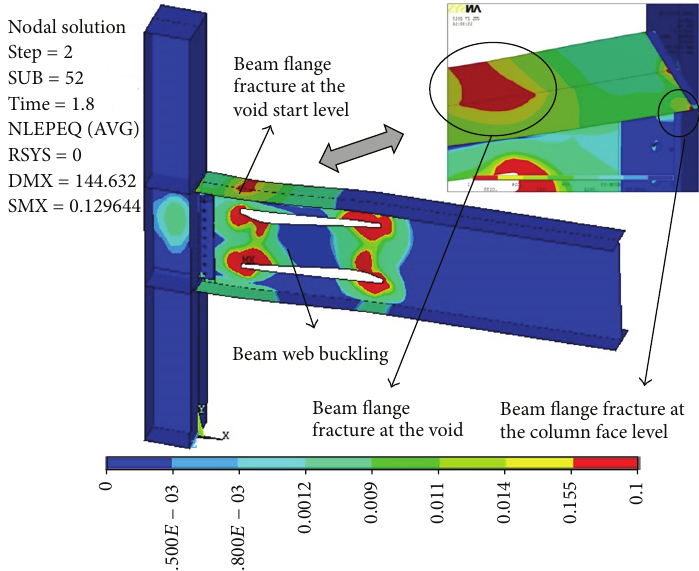
Figure 6: Plastic equivalent strain (PEEQ) distribution for modified specimen SAC7 with single voids at four percent total rotation.